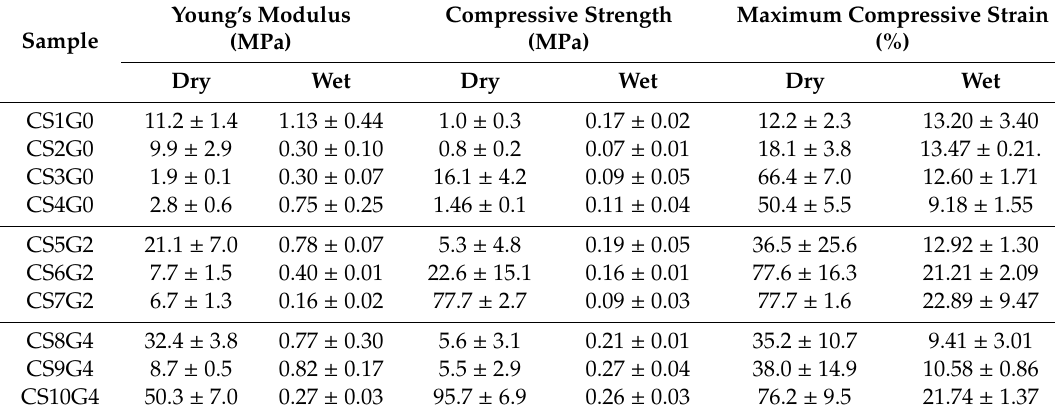
Table 3. Mechanical properties obtained from the uniaxial compression testing of the dry samples and wet samples after saturation by the absorption of PBS for CS / GPTMS-Silica aerogels; mean values ± standard deviation ( n =